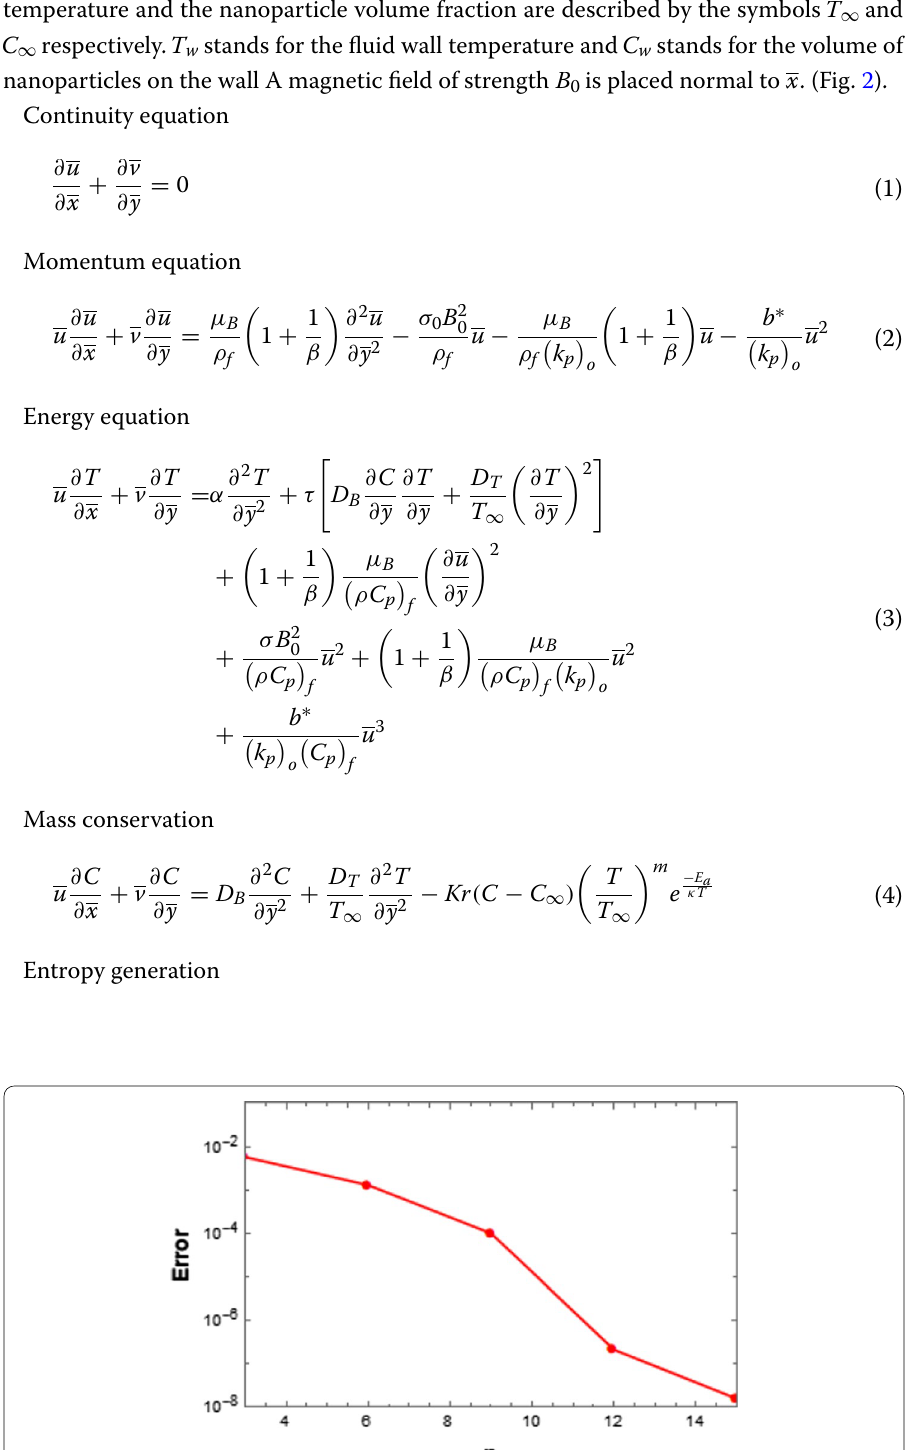
Fig. 2 The maximum average squared residual error at different orders of